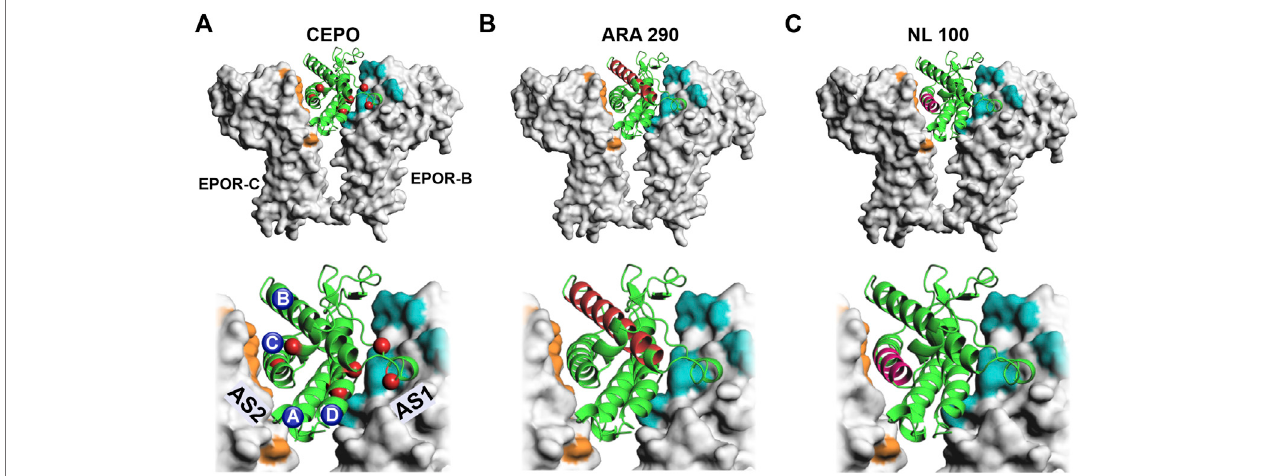
FIGURE1| Non-erythropoieticEPO-mimeticmolecules.EPO-mimeticmoleculesareshownsuperimposedontothecrystalstructureofEPOboundtoEPOR(PDB ID: 1EER) (Syed et al., 1998). In the top panel ’ s EPO (green cartoon) is shown bound to EPOR (gray) in molecular surface representation. High magni fi cation images are shown in the bottom panels. Active site 1 is colored in teal and active site 2 in orange. (A) Carbamoylated EPO is shown bound to EPOR with carbamoylated residues represented byred spheres.The 4helicesare labeled alphabetically. (B) Theresidues that comprise theARA290peptide from theBhelix areshown inred (Brines et al., 2008). (C) The residues that comprise the NL-100 peptide from the C helix are shown in magenta (Dmytriyeva et al., 2019). AS 1- Active site 1, AS 2 – Active site 2, EPOR-B – Erythropoietin receptor B chain, EPOR-C-Erythropoietin receptor C